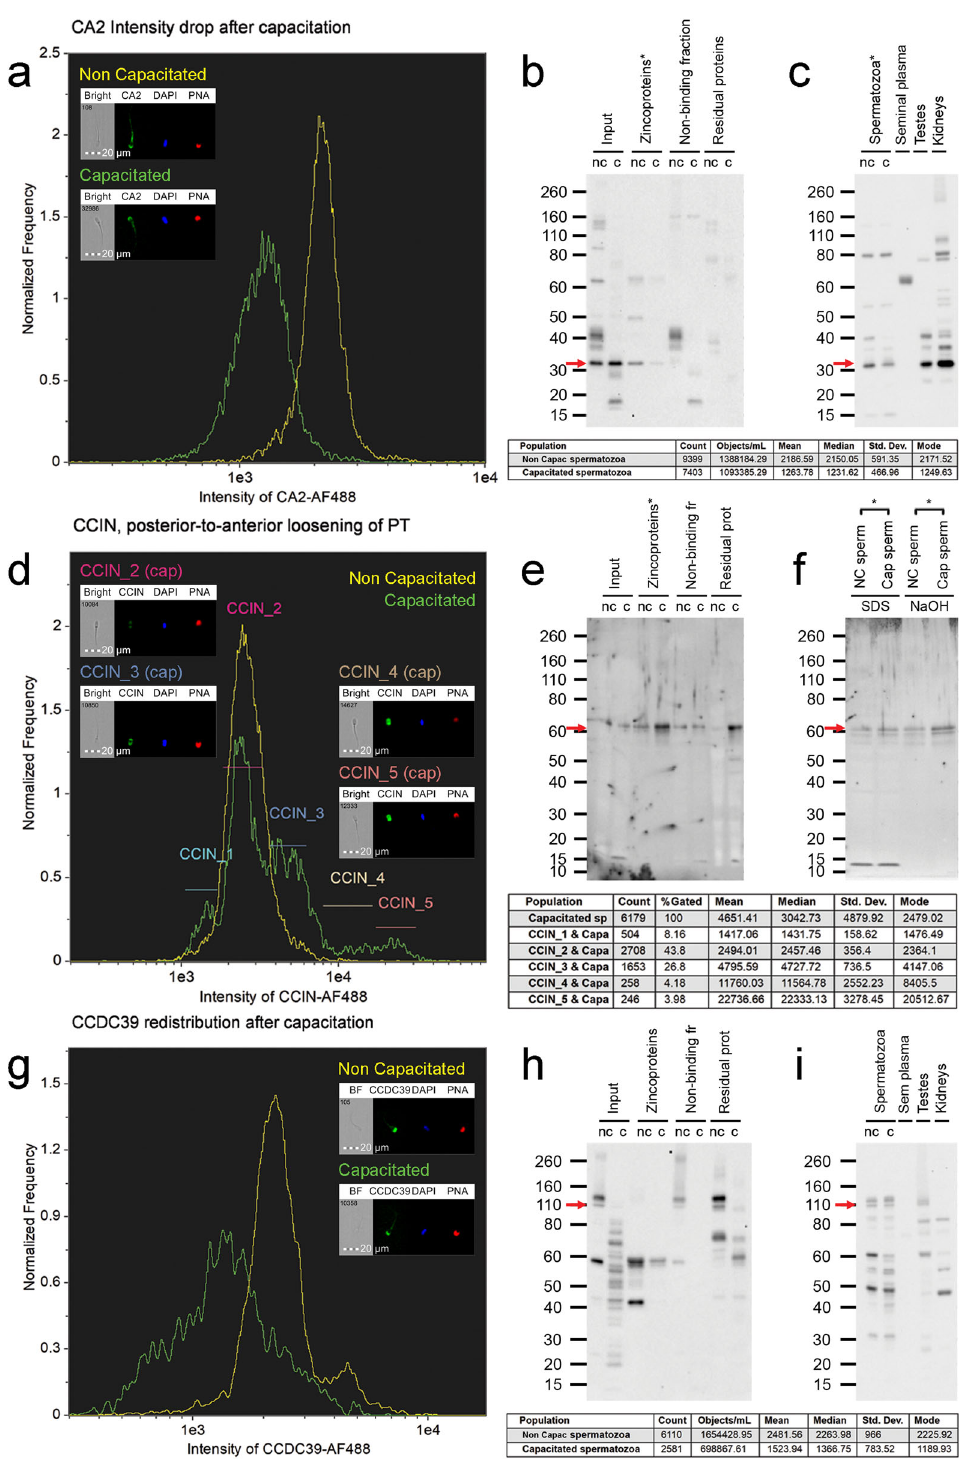
Fig. 6 Phenotyping of three signi fi cantly different zincoproteins between non-capacitated and IVC spermatozoa. a – c CA2, d – e CCIN, and g – i CCDC39. IBFC of formaldehyde fi xed and Triton X-100 permeabilized ( a , d ) or methanol fi xed/permeabilized ( g ) spermatozoa; labeled with corresponding primary antibodies. Appropriate species-speci fi c secondary antibodies conjugated to AF488 were used and coincubated with DAPI nuclear stain and PNA-AF647 for acrosome detection. Negative controls with respective non-immune sera of matching immunoglobulin concentration were performed and were published in our previous study. IBFC was performed in 5 replicates with consistent results. WB detection in individual fractions of zincoproteome puri fi cation ( b , e , h ), and WB detection in whole sperm extracts ( c , f , i ) were employed to fully characterize the capacitation changes in the studied proteins. The red arrows point to the bands of actual (CA2 ~ 32 kDa, CCIN ~ 60 kDa), and predicted (CCDC39 ~ 110 kDa) molecular weights.WB detection in sperm zincoproteome ( b , e , h ) and the whole sperm extracts ( c , f , i ) was performed in 8 replicates, and 3 replicates respectively. A statistically signi fi cant difference ( P < 0.05, two-sample t -test) between non-capacitated and capacitated spermatozoa is indicated by an asterisk.